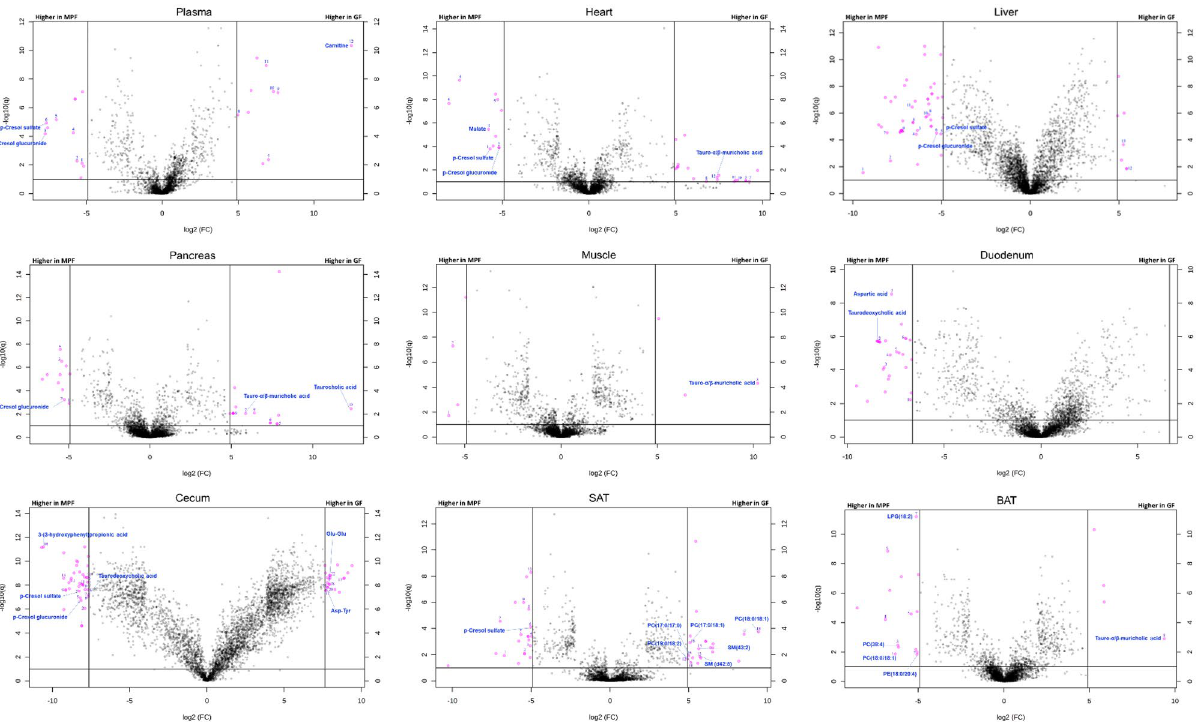
Figure 3. Volcano plots of the molecular features detected in nine representative tissues. The illustrated tissues include plasma, heart, liver, pancreas, muscle, duodenum, cecum, subcutaneous adipose tissue (SAT), and brown adipose tissue (BAT); see Supplementary Fig. 1 for volcano plots of all studied tissues individually with selected metabolites annotated. The binary logarithm of the fold change (FC) is shown as the function of the negative common logarithm of the q value (false discovery rate corrected p value). A positive log2(FC) signifies a higher abundance in the GF mice compared to the MPF mice. The purple dots represent molecular features Molecular features are presented as their binary logarithmic fold change [log2(FC)]against the negative common logarithm of the q value [false discovery rate corrected p value; − log10(q)] of the differential expression between the GF and MPF mouse group. Although the purple dots represent molecular features fulfilling the above-mentioned significance criteria, and were unique to the sample